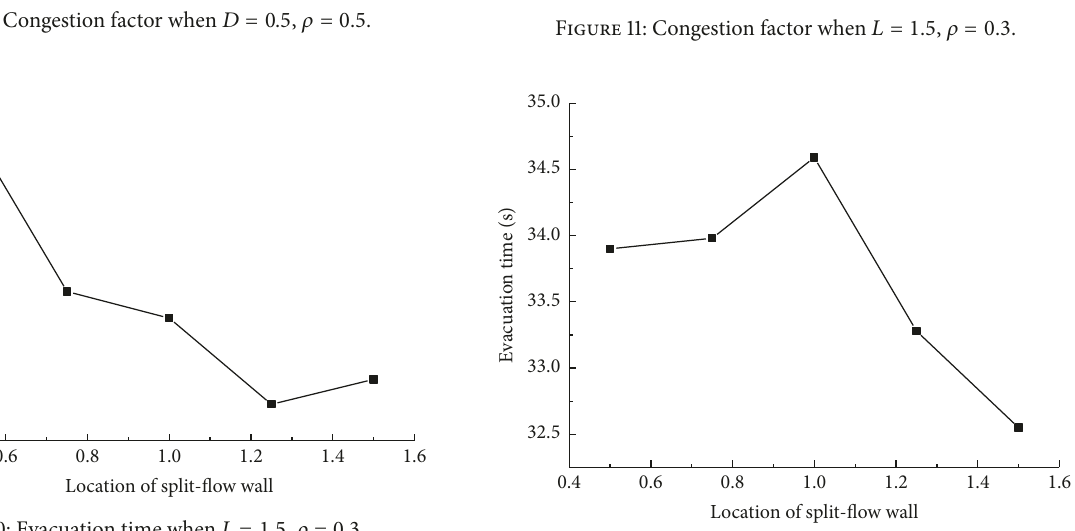
Figure 12: Evacuation time when 𝐿 = 2 , 𝜌 = 0.5 .